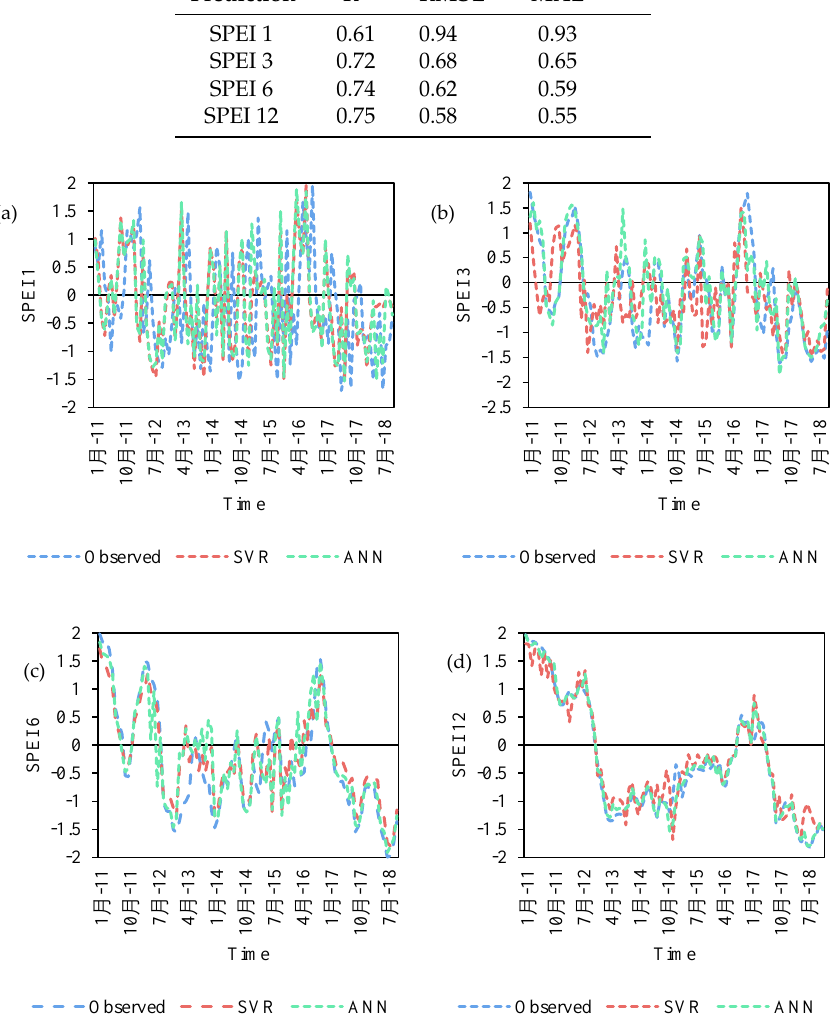
Figure 4. Variation in SPEI values at different time scales ( a ) 1 month; ( b ) 3 months; ( c ) 6 months; ( d ) 12 months between observed and predicted values using SVR and RNN.